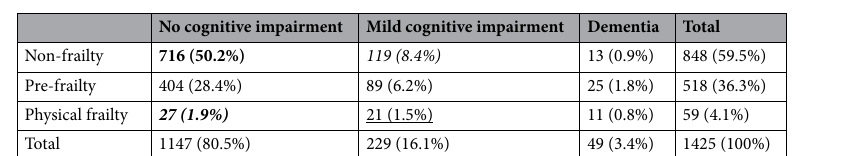
Table 1. Physical and cognitive status of individuals participating in the present survey. Numbers and proportions (percentages) are presented corresponding to the physical status (i.e., non-frailty, pre-frailty, physical frailty) and cognitive status (i.e., no cognitive impairment, mild cognitive impairment, and dementia). Four subject groups selected for the present study are defined as follows: (a) cognitive frailty (CF), which was diagnosed in cases where both physical frailty and mild cognitive impairment criteria were met, n = 21, underlined in the table; (b) non-cognitive-impaired physical frailty (nci-PF), n = 27, bolditalics; (c) non- physically frail mild cognitive impairment (npf-MCI), n = 119, italics; (d) normal control (NC), i.e., non- physically-frail non-cognitive-impaired, n = 716, bold.